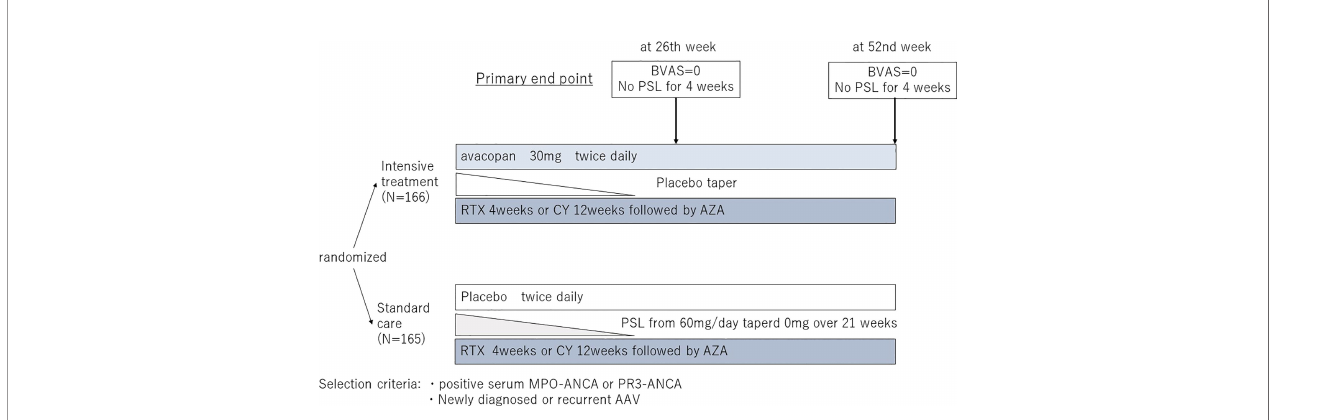
FIGURE 3 | The design of the ADVOCATE trial. BVAS, Birmingham Vasculitis Activity Score; PSL, prednisolone; RTX, Rituximab; CPA, Cyclophosphamide; AZA, Azathioprine; MPO-ANCA, myeloperoxidase-anti neutrophil cytoplasmic antibody; PR3-ANCA, proteinase3-anti neutrophil